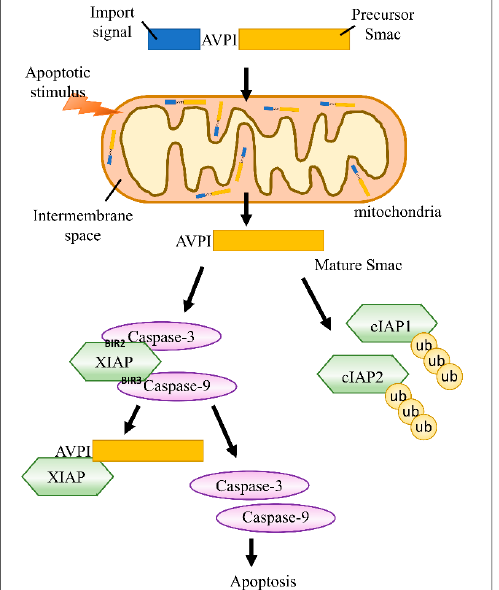
Figure 1. Smac/DIABLO inhibits IAPs in cancer cells. The precursor of Smac (yellow) is transported to the intermembrane space of mitochondria by the import signal (blue box). Then, mature Smac is released from the mitochondria into the cytosol and subsequently inhibits the cellular functions of IAPs. AVPI stands for “Ala ‐ Val ‐ Pro ‐ Ile”. BIR stands for “baculoviral IAP repeat”. Ub stands for “ubiquitin”.